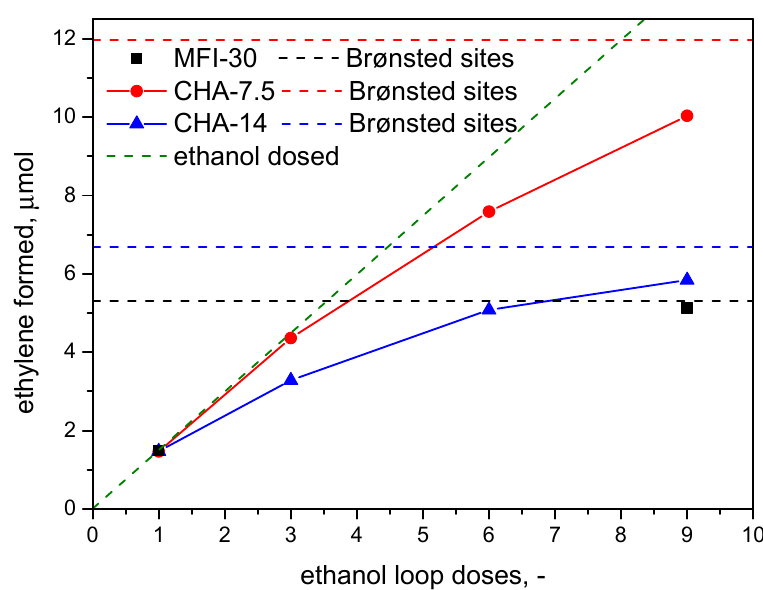
Figure 3. Amount of ethylene formed during TPSR experiments (from experiments with β = 10 K · min − 1 ).